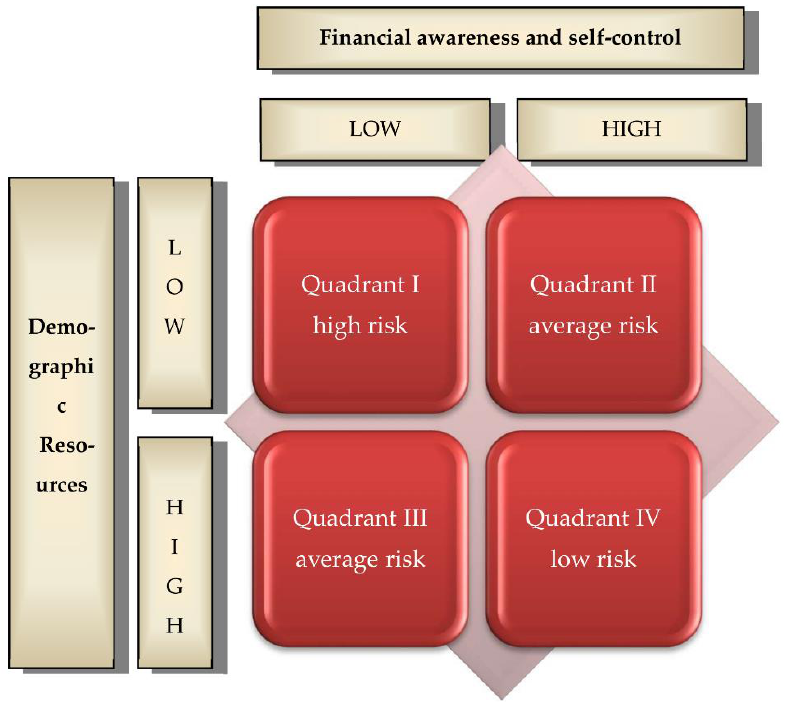
Figure 2. The common profiles of consumers’ financial risk behaviors. Source: based on [17].